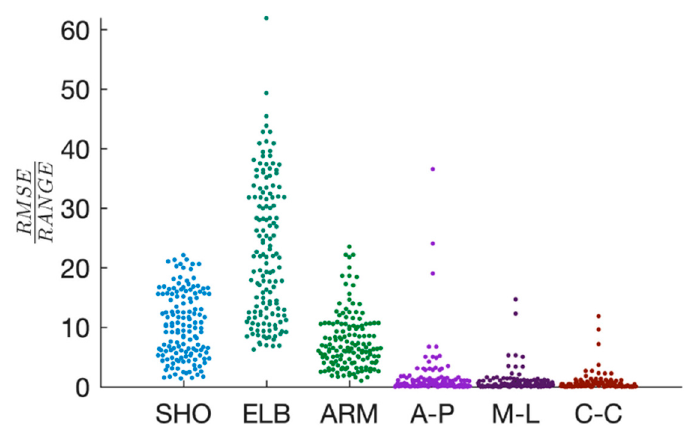
Figure 4. Distribution plots showing tracking performance reported as root mean squared error (RMSE) expressed as percentage of maximal range of motion or acceleration. Shoulder (SHO) and forearm (ARM) angles were directly tracked within the optimization, as well as anterior–posterior (AP), medial–lateral (ML) and cranial–caudal (CC) hand acceleration components. Elbow joint angle (ELB) error is also shown, although this angle was not directly tracked within the optimization.